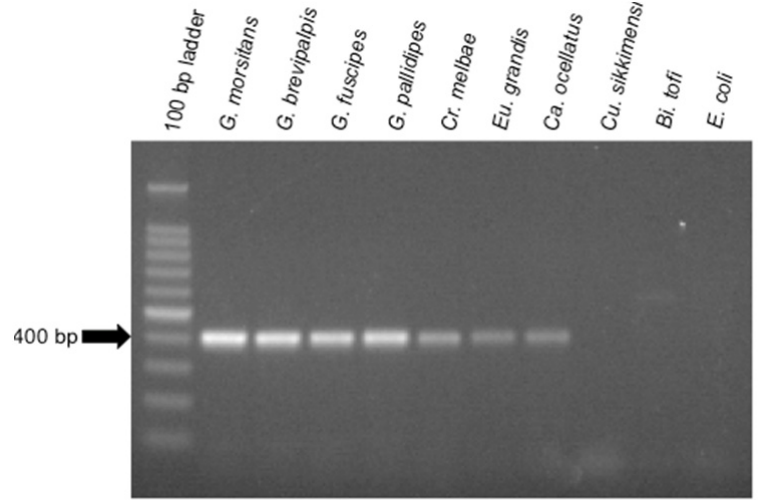
Figure 3. Diagnostic PCR detection of Sodalis and allied insect symbionts using ITS